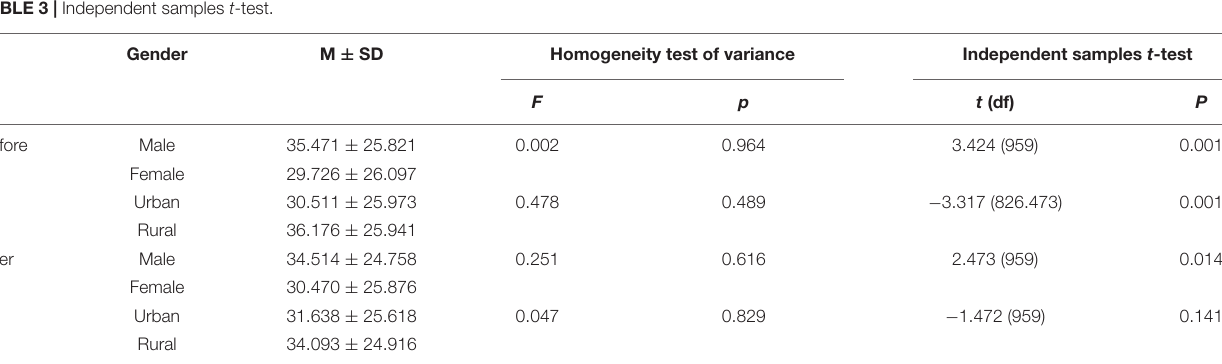
TABLE 3 | Independent samples t